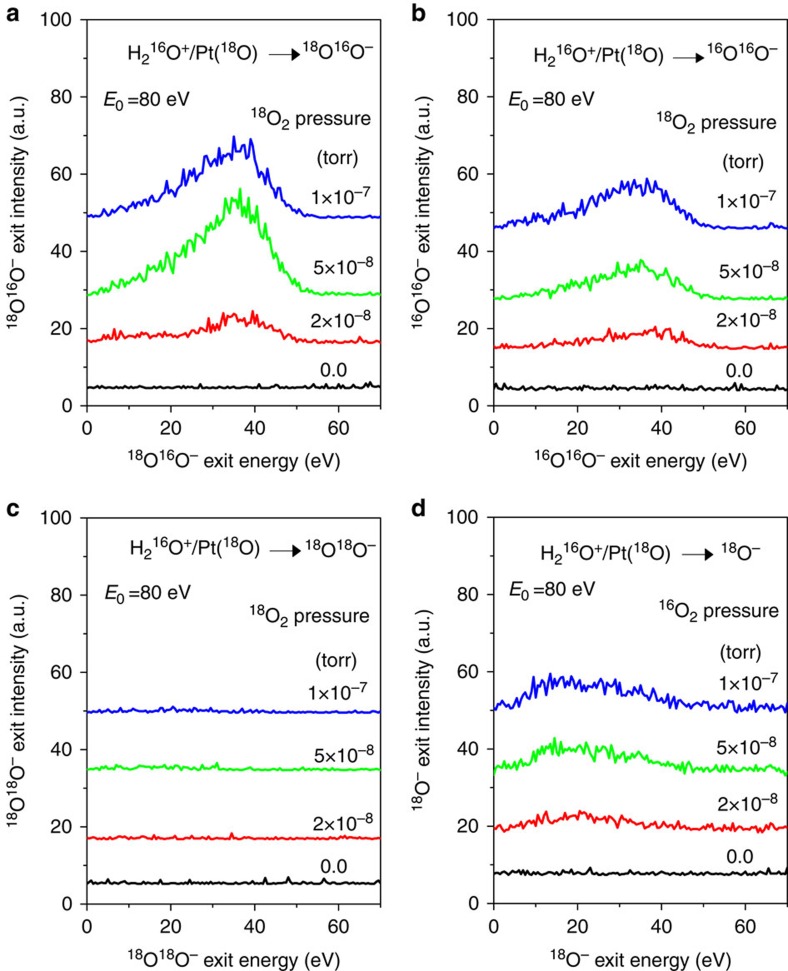
Isotopic dosing experiments of H2O+ scattering on Pt covered with 18O atoms.Energy distributions of ion exits of (a) 18O16O−, (b) 16O16O−, (c) 18O18O− and (d) 18O− from H2O+ scattering on Pt at various 18O2 exposure pressures, as annotated. The detection of 18O16O− in a indicates fast O2− formation between 16O-atoms from H216O+ and 18O-atoms adsorbed on the Pt surface. The absence of 18O18O− in c proves that fast O2− may not originate in the gas phase or from surface sputtering. The 16O16O− formation in b is due to the oxygen deposition on the Pt surface from collision-induced dissociation of H216O+ (see text). The appearance of 18O− sputtering peak ∼25 eV in d confirms that the surface is covered by 18O atoms, produced by in situ18O2 exposure.